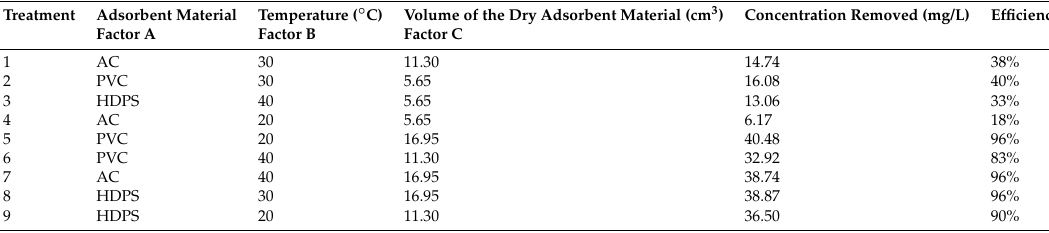
Table 2. Results of the experimental runs carried out based on L9 orthogonal